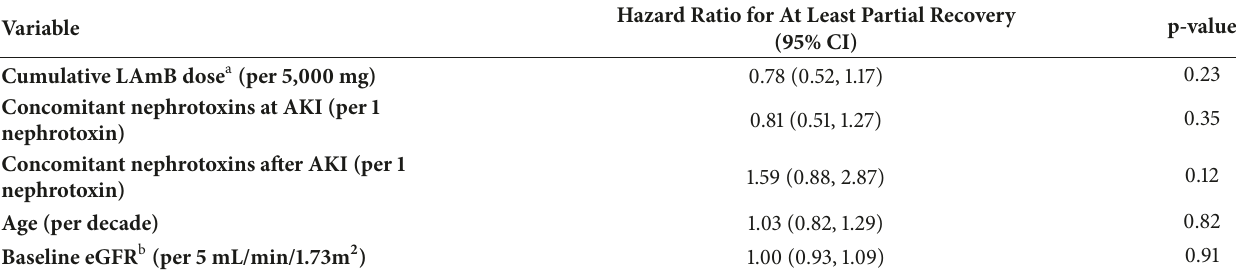
Table 3: Multivariable Cox model.